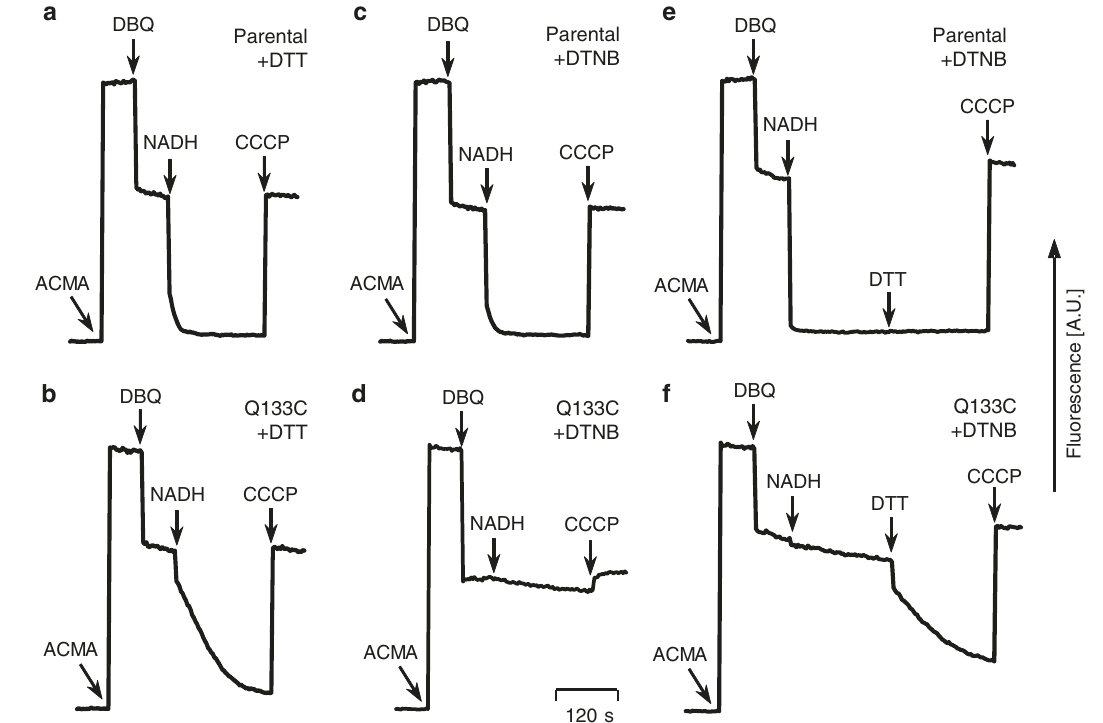
Fig. 3 Blocking movement of loop TMH1-2 ND3 reversibly disengages the proton pumps. Proton pumping was monitored as 9-amino-6-chloro-2- methoxyacridine (ACMA) fl uorescence quench in proteoliposomes containing either parental or mutant complex I treated with 5 mM dithiothreitol (DTT) ( a , b ) or 0.1 mM 5,5 ′ -dithiobis-2-nitrobenzoic acid (DTNB) ( c – f ) for 5 min before starting the assay. As indicated, 0.5 µ M ACMA, 70 µ M decylubiquinone (DBQ). 100 µ M NADH and 5 µ M carbonylcyanide m -chlorophenylhydrazine (CCCP) were added during the assay. Addition of 5 mM DTT to DTNB treated proteoliposomes during the assay had no effect on parental complex I ( e ), but rapidly restored proton pumping of the mutant enzyme ( f ). Representative traces of one out of four datasets obtained with independent batches of proteoliposomes are